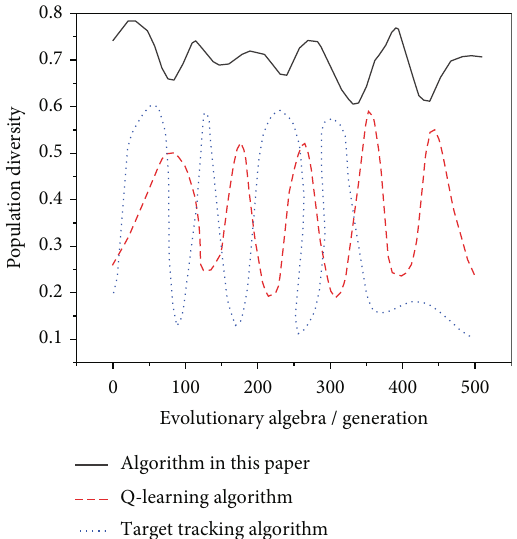
Table 2: Comparison of evolution algebra of Q -learning algorithm/ generation.